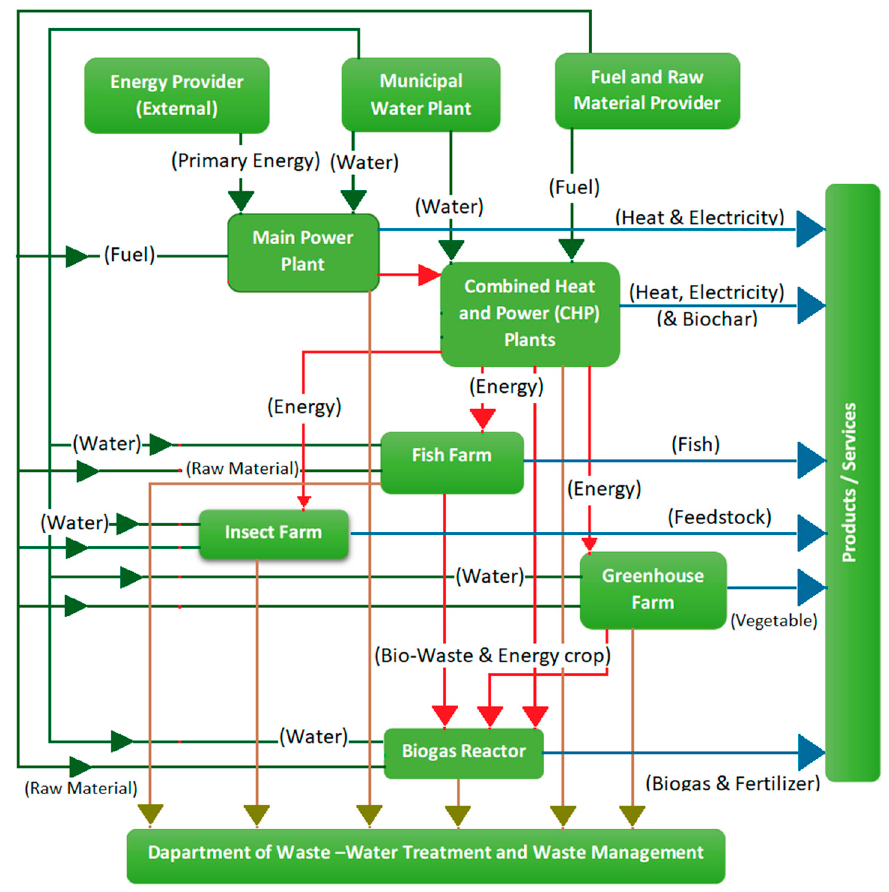
Figure 3. The architecture and material flow of industrial symbiosis in Sodankylä. Green color represents the input; blue color depicts the output and red color reflects the material exchange.